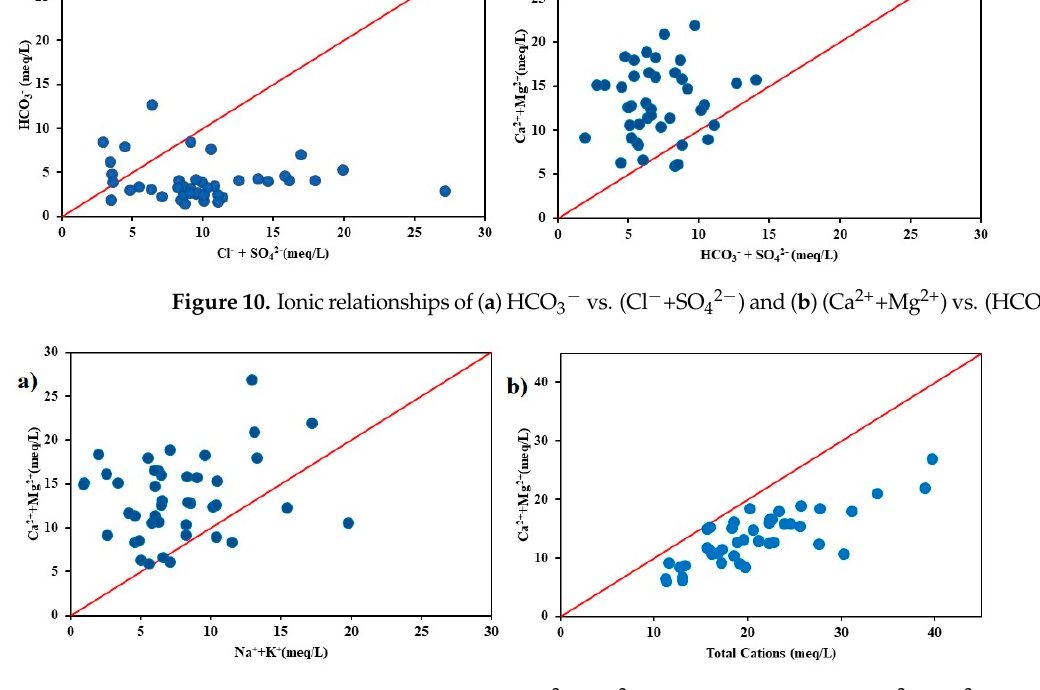
Figure 11. Ionic relationships of ( a ) (Ca 2+ +Mg 2+ ) vs. (Na + +K + ) and ( b ) (Ca 2+ +Mg 2+ ) vs. total cations .